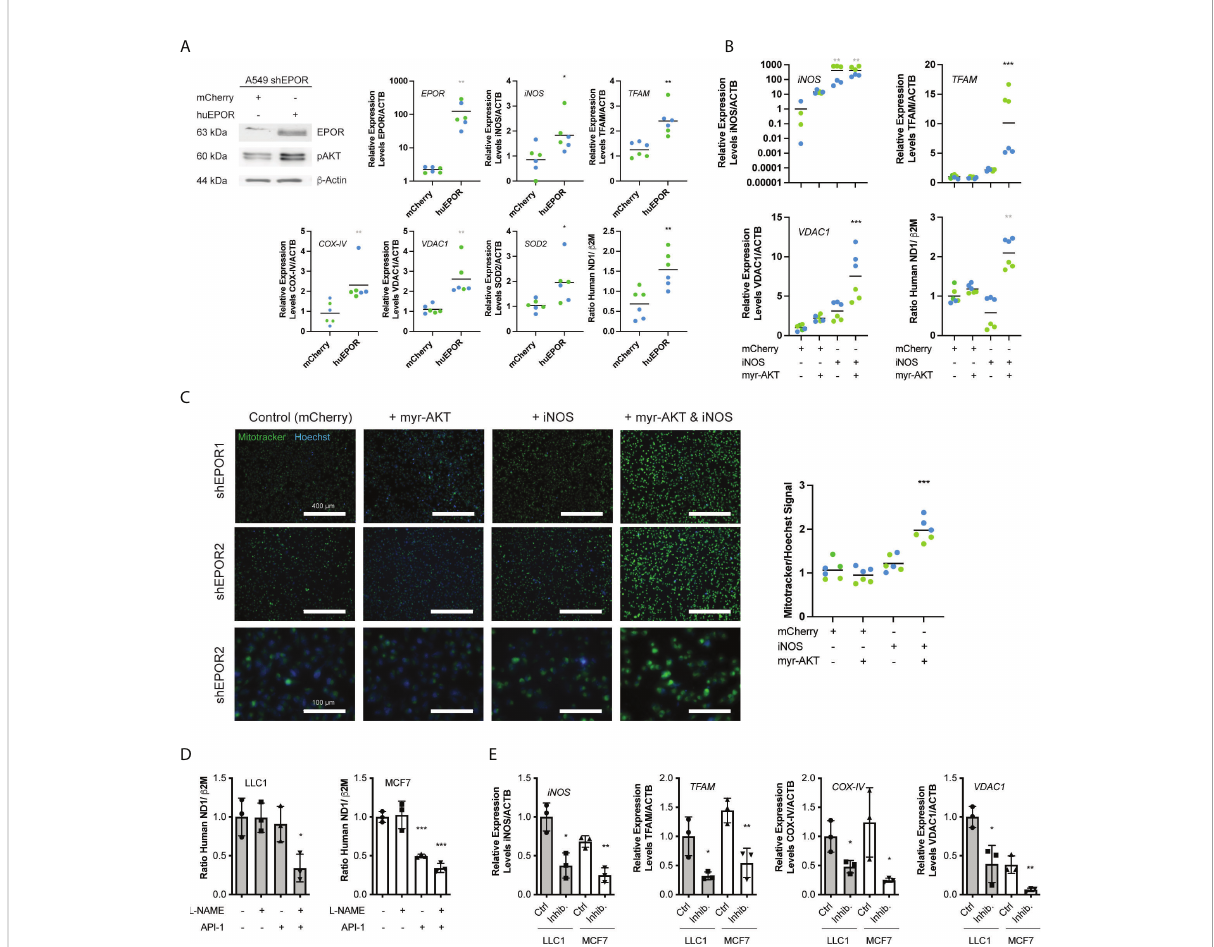
FIGURE 5 iNOS and AKT are required to mediate the EPOR effect on mitochondrial biogenesis. A549 shEPOR1 (green symbols) and shEPOR2 (blue symbols), LLC1 murine Lewis lung carcinoma cells (grey bars), and human MCF-7 breast cancer cells (white bars) were cultivated in vitro . (A) EPOR- knockdown shEPOR1 A549 cells were transfected with huEPOR or a control (mCherry) plasmid, and 72 h after transfection, mRNA and protein were isolated. Shown is a representative western blot image of human erythropoietin receptor (EPOR) (63 kDa), pAKT (60 kDa), and loading control b - actin (44 kDa) (left panel), as well as mRNA levels of erythropoietin receptor ( EPOR ), inducible nitric oxide synthase ( iNOS ), transcription factor A, mitochondrial ( TFAM ), cytochrome c oxidase subunit 4.2 ( COX-IV ), voltage-dependent anion-selective channel 1 ( VDAC1 ), and superoxide dismutase 2 ( SOD2 ) quanti fi ed by qPCR and normalized to b -actin ( ACTB ) mRNA (n=6). Further shown is mitochondria content (right panel) determined by the ratio of human MT-ND1 (mitochondrially encoded NADH dehydrogenase 1) mitochondrial DNA to b 2M ( b -2microglobulin) genomic DNA, which was quanti fi ed by qPCR from genomic DNA extracts. (B) EPOR-knockdown shEPOR1 and 2 A549 cells were incubated with lentiviral vectors to stably express inducible nitric oxide synthase (iNOS) or mCherry (control). Additionally, cells were transfected with a plasmid to overexpress constitutively active myr-AKT (24). The cells were incubated for 72 h, and mRNA was isolated. iNOS , TFAM , and VDAC1 mRNA levels were quanti fi ed using qPCR and normalized to ACTB. Furthermore, the mitochondria content (right lower panel) was determined by the ratio of human MT-ND1 (mitochondrially encoded NADH dehydrogenase 1) mitochondrial DNA to b 2M ( b -2microglobulin) genomic DNA, which was quanti fi ed by qPCR from genomic DNA extracts (n=6). (C) Shown are images of shEPOR1 (upper row) and shEPOR2 (middle and bottom rows) of A549 cells stably expressing iNOS or mCherry (control) and were transfected with a plasmid to myr-AKT or not. Cells were incubated with Mitotracker (green) and Hoechst (blue), and images were taken using a fl uorescence microscope and quanti fi ed using ImageJ. Shown in the right panel is the Mitotracker signal normalized to the Hoechst signal (n=4-6). (D) Murine LLC1 (grey bars) and human MCF-7 cells (white bars) were incubated with 200 µM L-NAME and/or 5 µM API-1 for 72 h. Mitochondrial content was determined by the ratio of murine (LLC1) or human (MCF7) MT-ND1 (mitochondrially encoded NADH dehydrogenase 1) mitochondrial DNA to murine or human b 2M ( b -2microglobulin) genomic DNA, which was quanti fi ed by qPCR from genomic DNA extracts (n=3). (E) Further shown are RNA levels of iNOS , TFAM, COX-IV , and VDAC1 quanti fi ed by qPCR and normalized to ACTB from LLC1 and MCF-7 cells either treated in vitro for 72 h with 200 µM L-NAME + 5 µM API-1 (Inhib.) to simultaneously inhibit iNOS and AKT or not (Ctrl.) (n=3). Data are shown as scattered blots with mean and individual data distribution of each clone (shEPOR1 green and shEPOR2 blue) or as bars with scatter dot plots (LLC1 grey and MCF-7 white). Data were analyzed by a Student ’ s t-test (black stars), a Mann-Whitney test (grey stars), an one-way ANOVA with Bonferroni post hoc test (black stars), or a Kruskal Wallis test with Dunn ’ s multiple comparison test (grey stars) (***p<0.001; **<0.01;